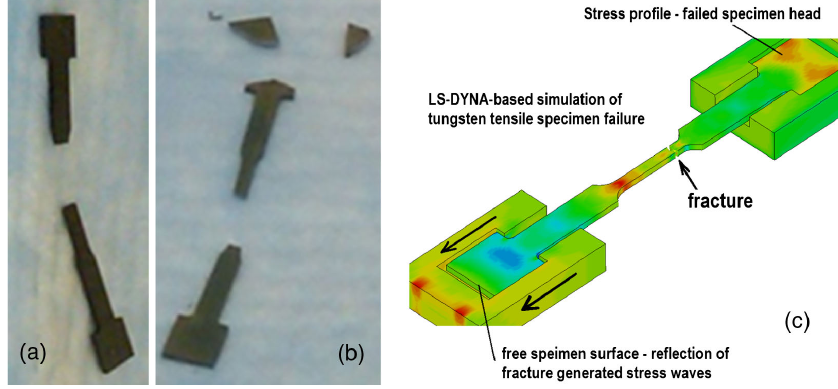
FIG. 28. Tensile test fracture of tungsten (a) unirradiated, (b) irradiated and (c) simulated.